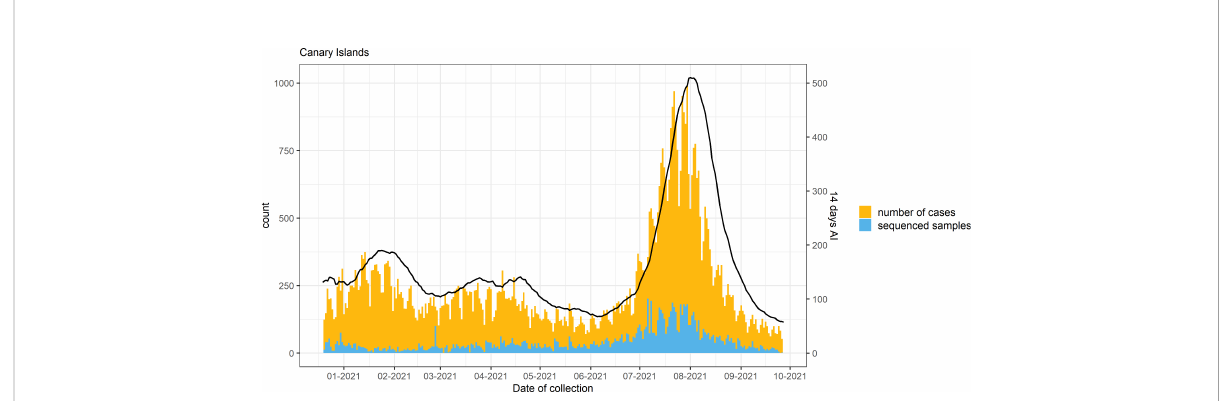
FIGURE 2 Number of cases, sequenced samples, and the 14-day accumulated incidence (AI; continuous line) throughout the study period in the Canary Islands